Question: Briefly state, in one sentence, what is plotted here.
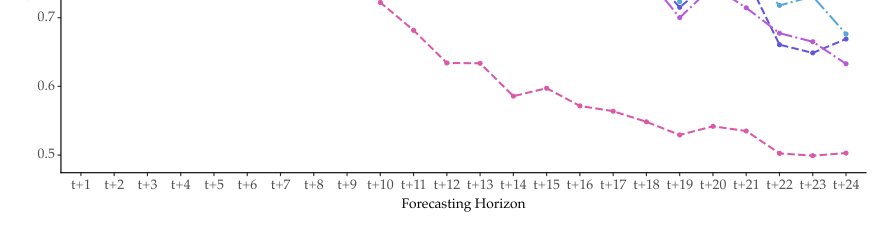
Answer: shows the AUC score for each method across the forecasting horizons. There is a generalized tendency for decreasing scores as the forecasting horizon in- creases (RQ3). This is expected as predicting further into the future represents a more difficult task.